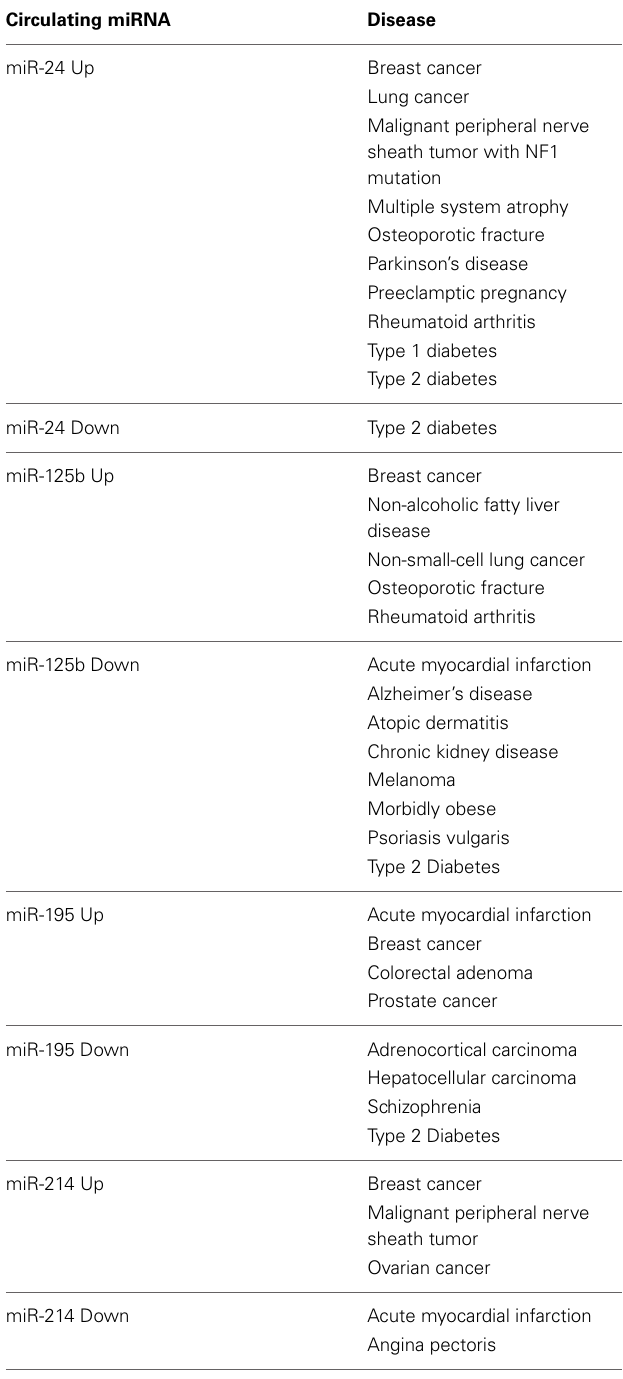
Table 3 | Circulating miR-24, miR-125b, miR-195, and miR-214 in